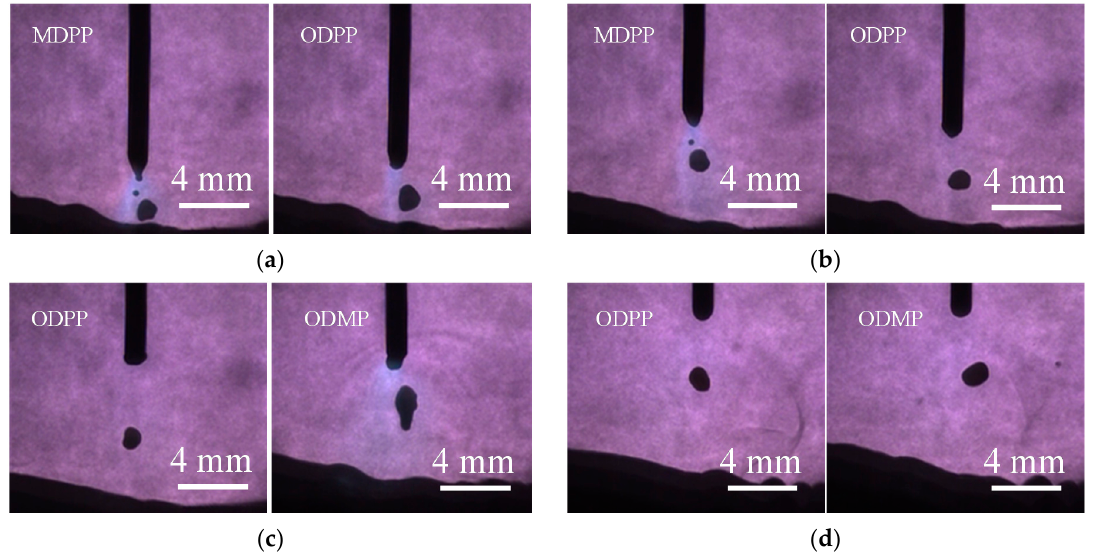
Figure 11. The typical droplet morphology of different types of projected transfer: ( a ) Test 3; ( b ) Test 4; ( c ) Test 5; ( d ) Test 6.